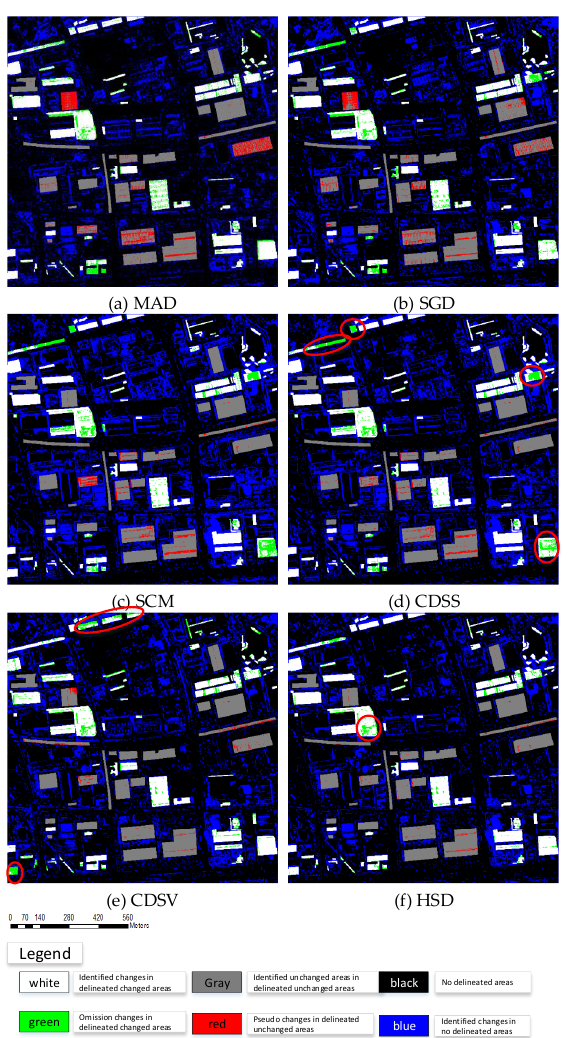
Figure 4. Change maps produced by different algorithms.